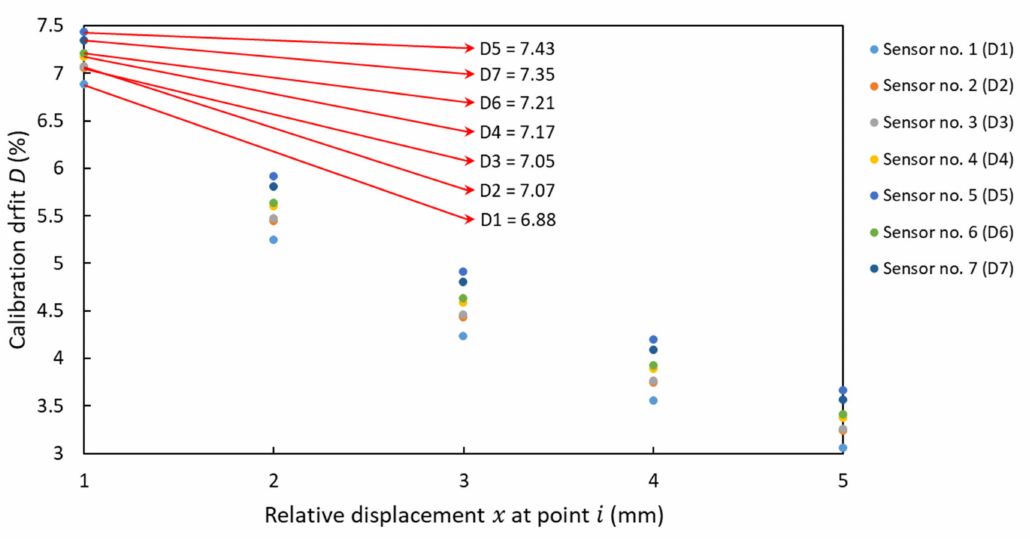
Figure 5. The drift in calibrations for seven sensors (D1 to D7) at 5